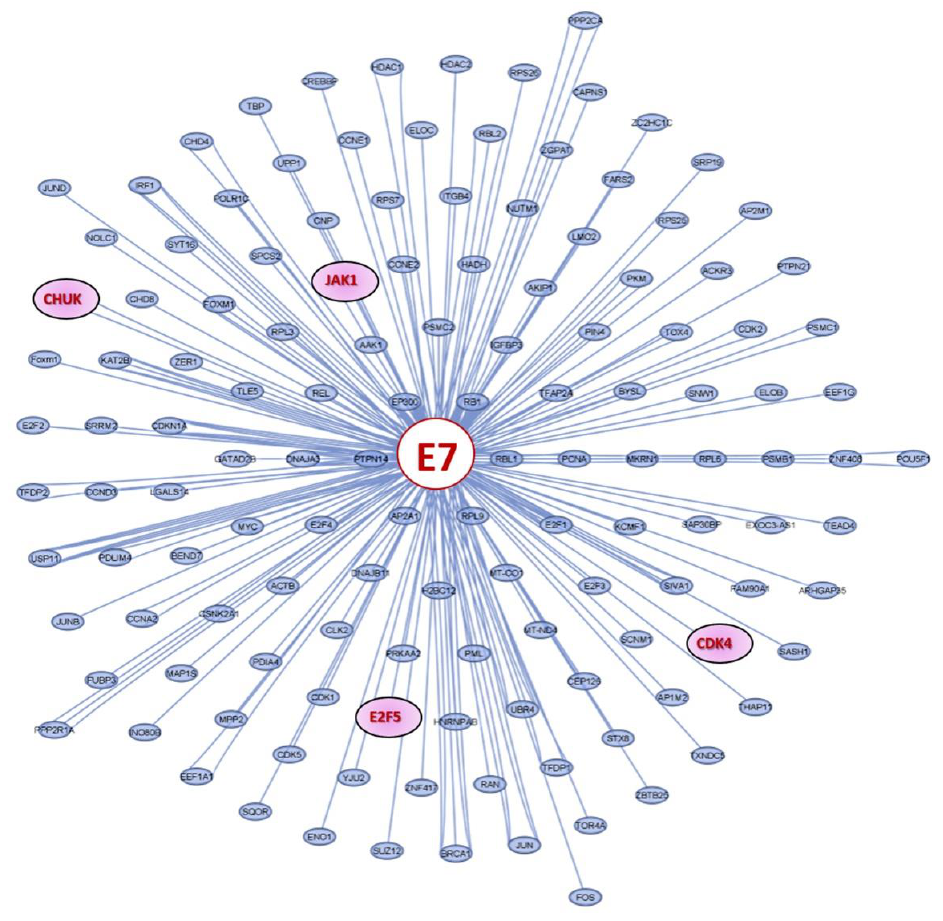
Figure 5. Proteins regulated by HPV-16 E7. The proteins encoded by the target mRNAs of miR- 23b-3p, miR-124-3p, or miR-218-5p are colored in red. 3p, miR-124-3p, or miR-218-5p are colored in